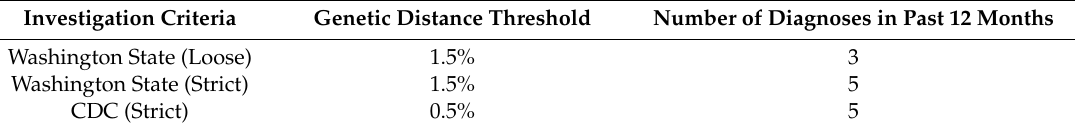
Table 1. Centers for Disease Control and Prevention (CDC) and proposed Washington State criteria for cluster